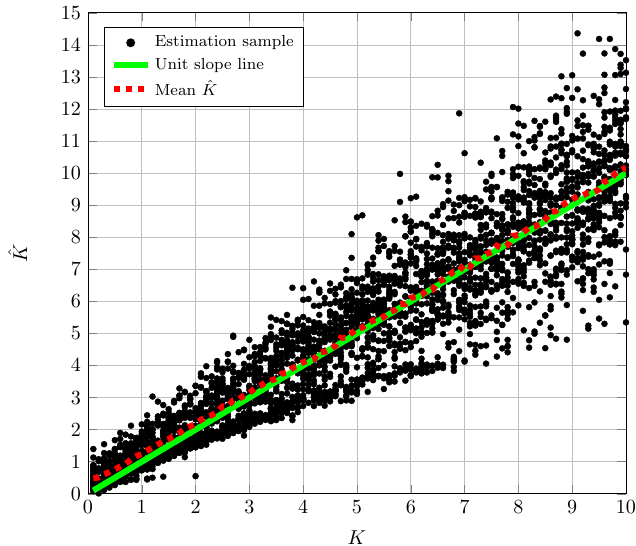
Figure 3. Samples of ˆ K using Equation (14) vs. true K for ∆ = 0.5.